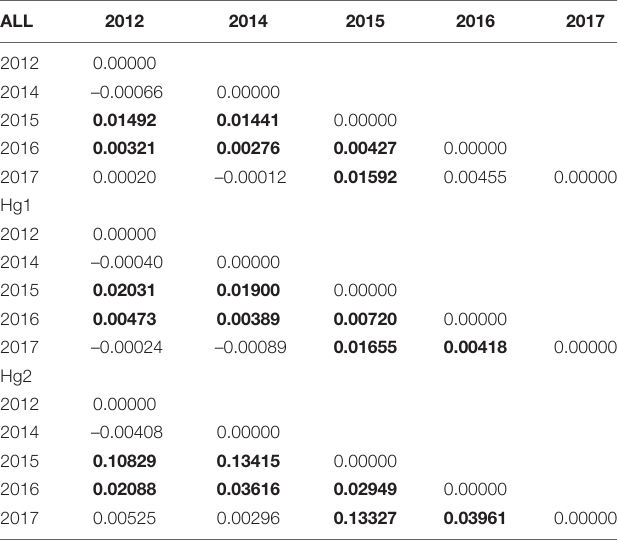
TABLE 5 | Genetic differentiation ( F ST ) values of the complete COI dataset, Hg1 and Hg2 in Pyura chilensis between years, calculated with haplotype frequencies. ALL